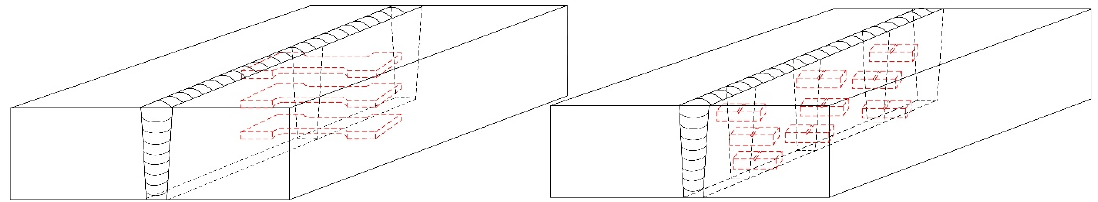
Figure 2. Sampling positions of mechanical property test samples.